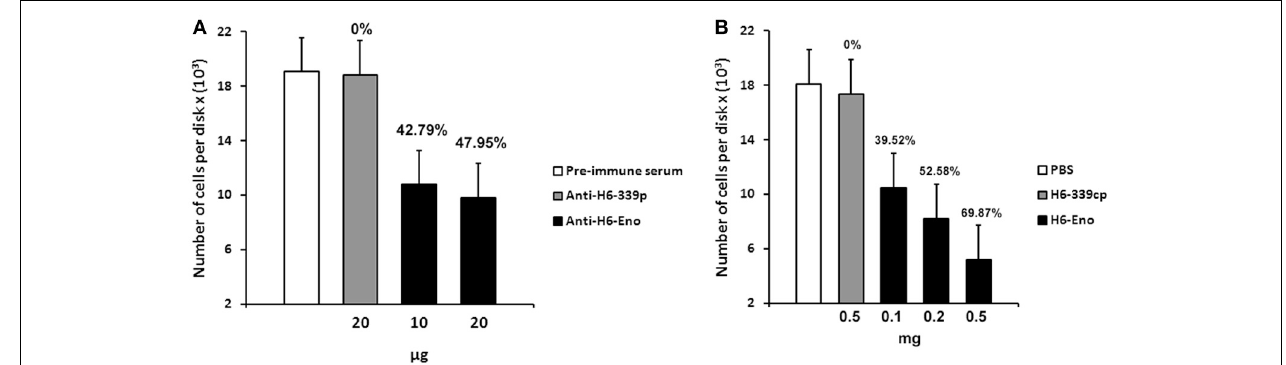
FIGURE 6 | Inhibition of C. albicans adhesion to mice gastrointestinal (GI) tissue disks. (A) Preincubation of C. albicans yeasts strain SC5314 with different concentrations of purified polyclonal anti His 6 -enolase (10 and 20 μ g) inhibited its adhesion to GI disks in comparison with the negative controls (20 μ g of polyclonal purified anti His 6 -CaYlr339cp or pre-immune serum). Data represent mean number of cells per tissue disks × (10 3 ) based on colony-forming units (cfu) counting of three independent experiments performed in triplicate. Bars represent the standard error (SE) of the means. Percentage values above the bars represent the percentage inhibition of adhesion with the negative control